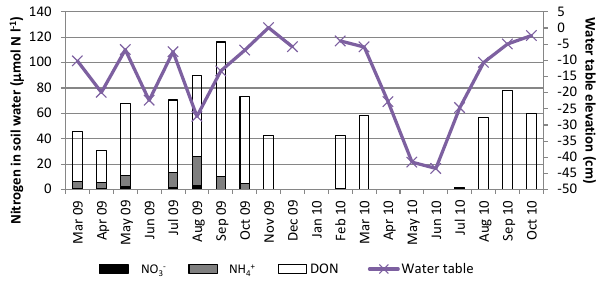
Figure 3. Monthly concentrations of NH + DON (white) in soil water. The line represents monthly water ta- ble elevation. The June 2009 sample was misplaced and Decem- ber 2009 and January 2010 were frozen; the remaining blank spaces indicate that the dip wells were dry on the day of